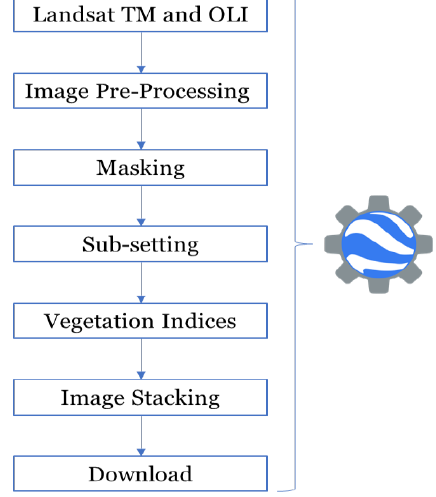
Figure 2: Diagram of the image processing